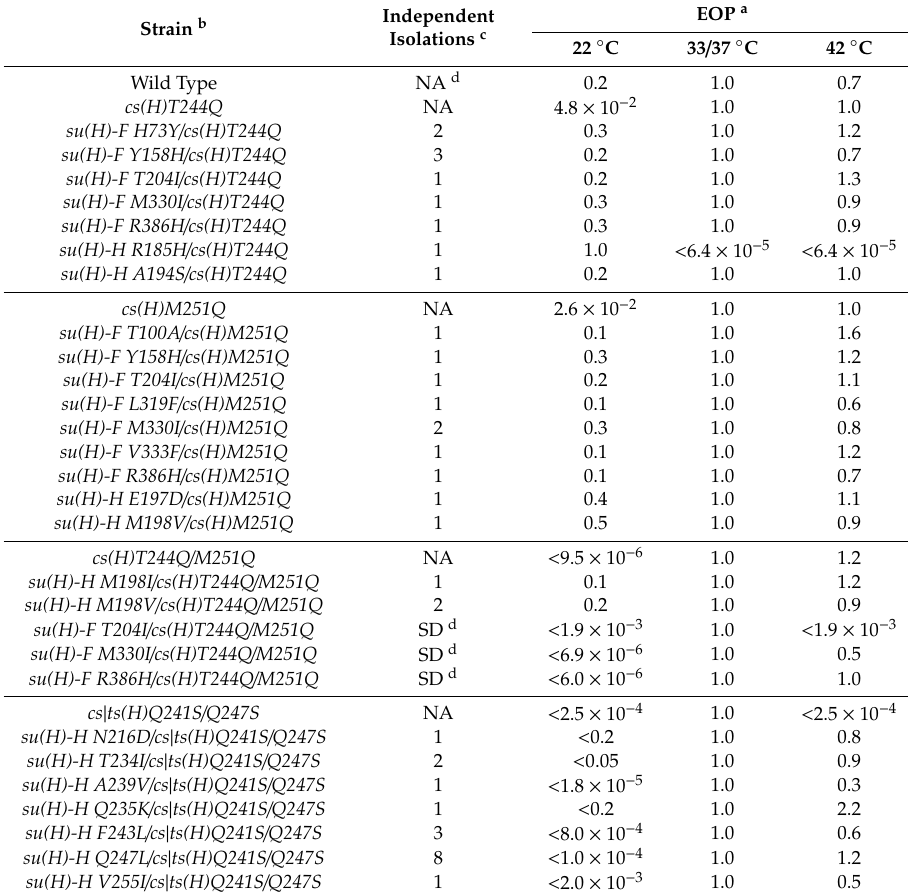
a E ffi ciency of plating. Values are normalized to those obtained at 37 ◦ C for cs mutants, and at 33 ◦ C for cs | ts mutants. b Suppressing mutations are named with the gene in which the nucleotide substitution was found and the resulting amino acid change. Thus, su(H)-F H73Y indicates a suppressor of an H defect in gene F,